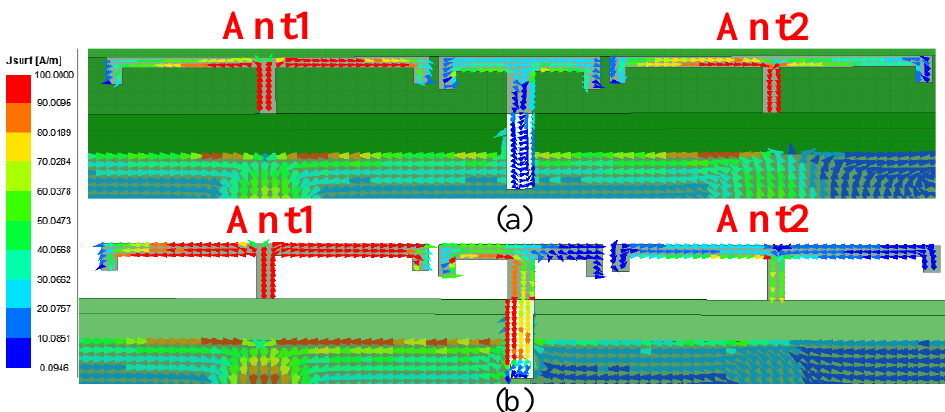
Figure 4. ( a ) Current distribution when Ant1 is excited without Via5. ( b ) Current distribution when Ant1 is excited with Via5.